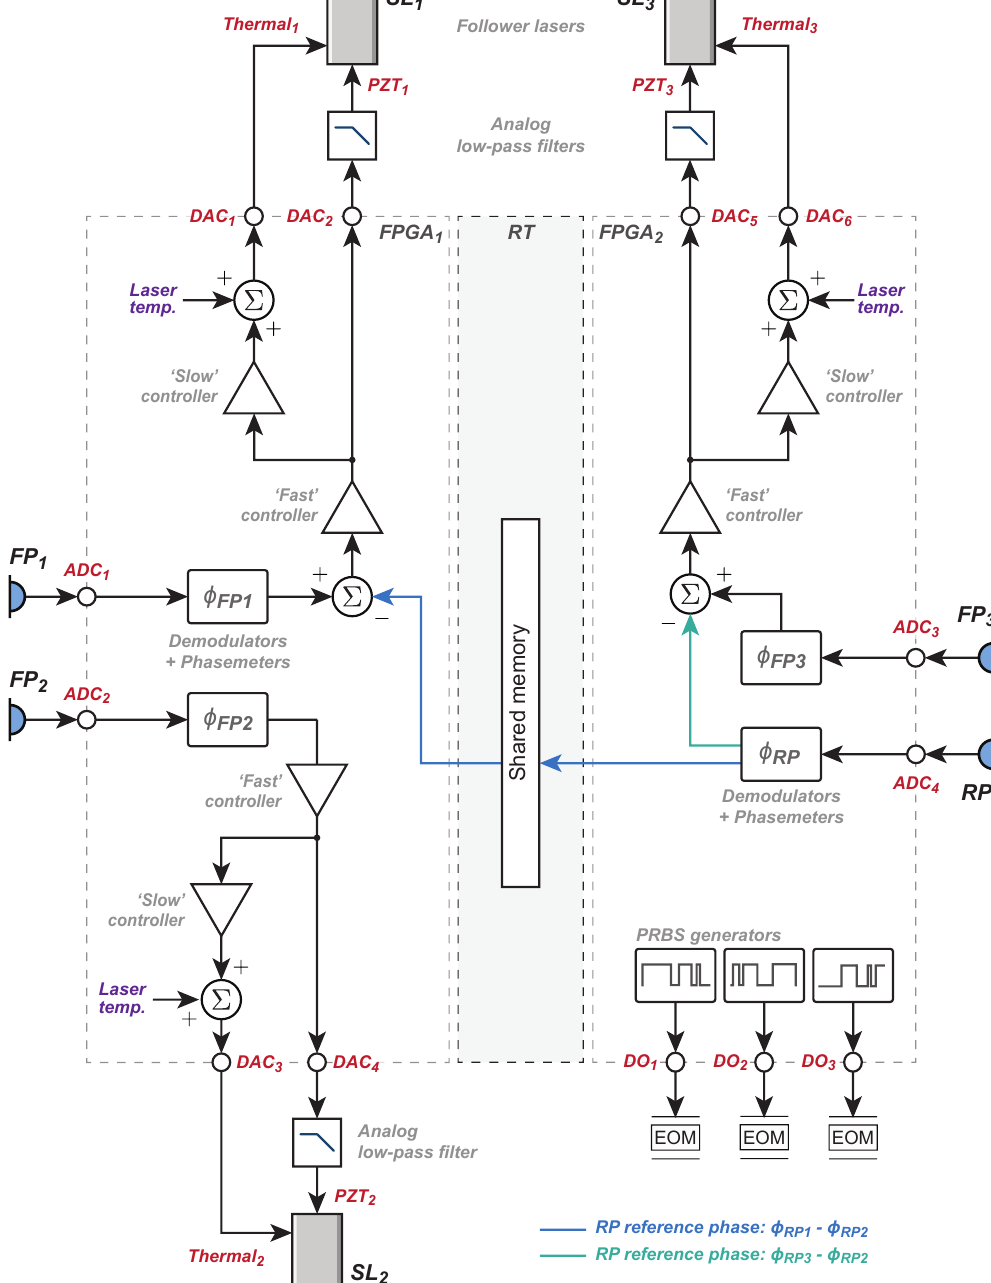
Figure 6. Digital signal processing architecture for the offset phase-locked OPA showing the shared allocation of DSP resources between two FPGAs. The FPGAs’ clocks are phase-locked to a common 10 MHz reference. Data are transferred from one FPGA to the other via shared memory administered by a real-time (RT)